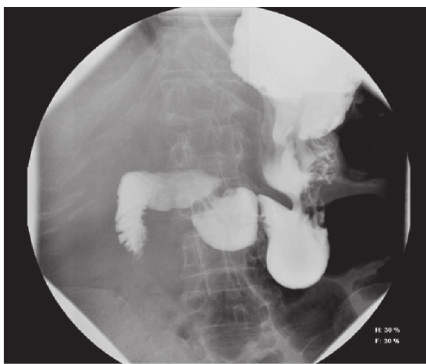
Figure 3: X-ray small bowel follow-through partial obstruction in the 2 nd portion of the duodenum as evidenced by narrowing without contrast